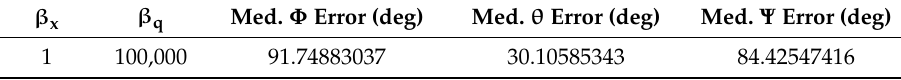
Table 4. Euler angle errors of the exponential-based model.